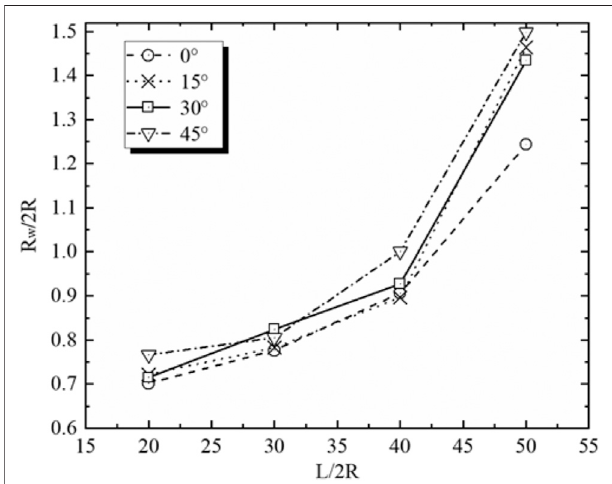
FIGURE 8 | Crossplot of two dimensionless parameters (Rw/2R and L/ 2R) for the determination of optimal measuring windows in the single-crack DEM-DFN model.